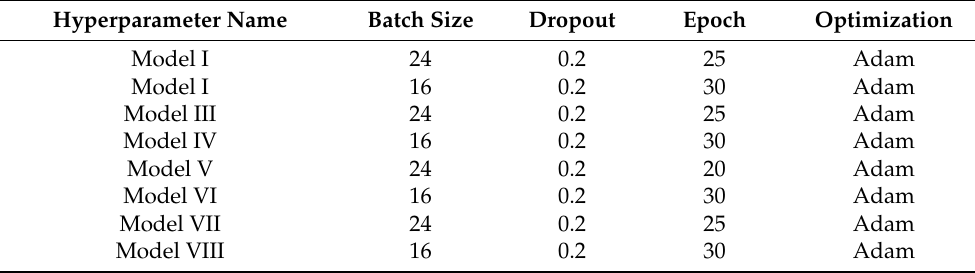
Table 4. Parameters and values of